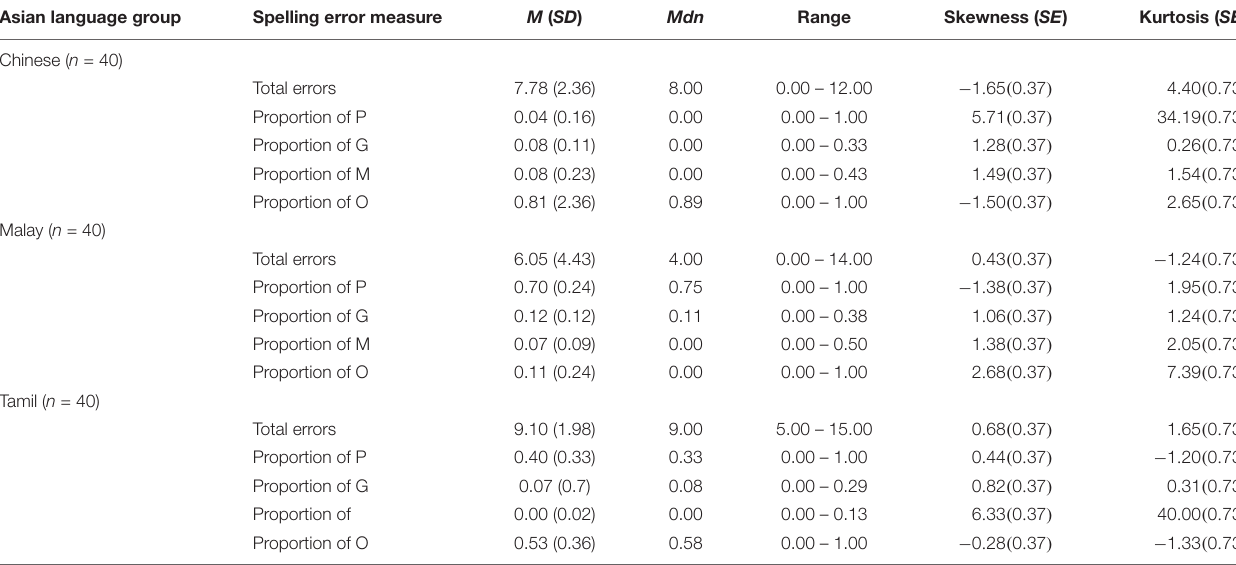
TABLE 5b | Average overall errors and proportions of error types for Asian language groups across the subsample ( N = 120). Asian language